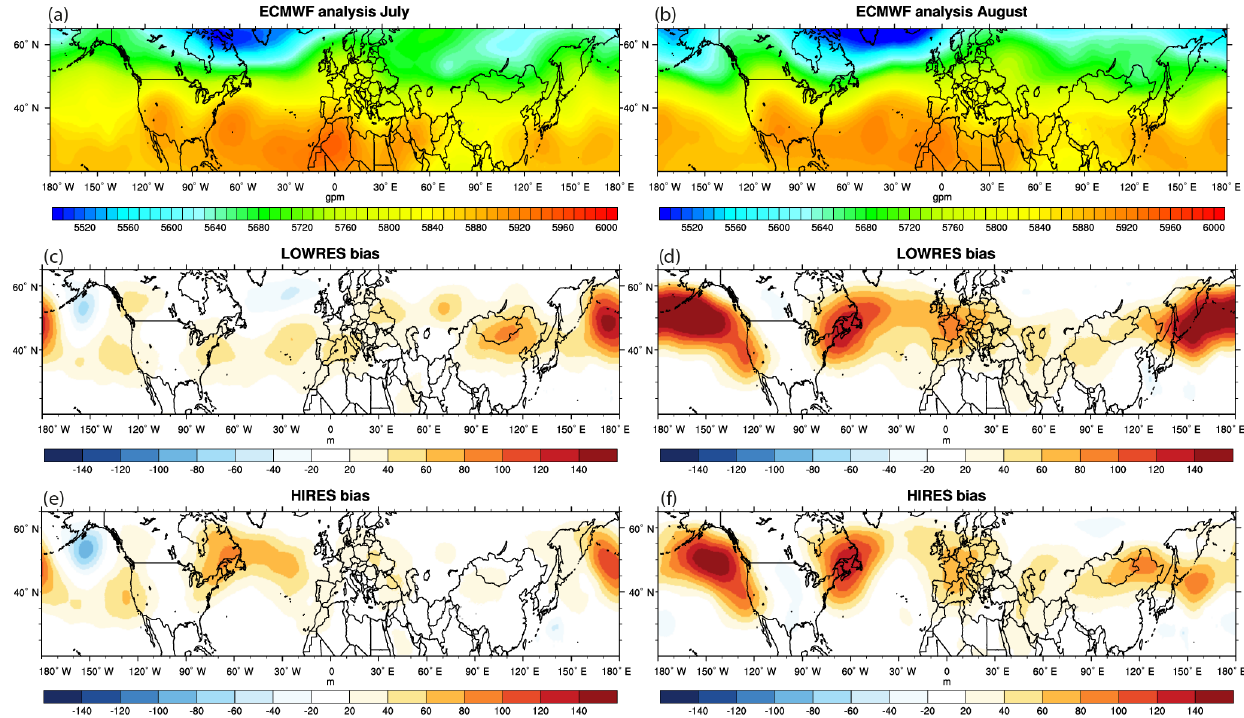
Figure 9. Mean 500hPa geopotential height and mean differences between the WRF simulations and ECMWF analysis at the 12:00UTC time steps for July 2013 (a, c, e) and August 2013 (b, d, f) . The top row shows the ECMWF analysis, the middle row shows the LOWRES simulation, and the bottom row displays the HIRES simulations.